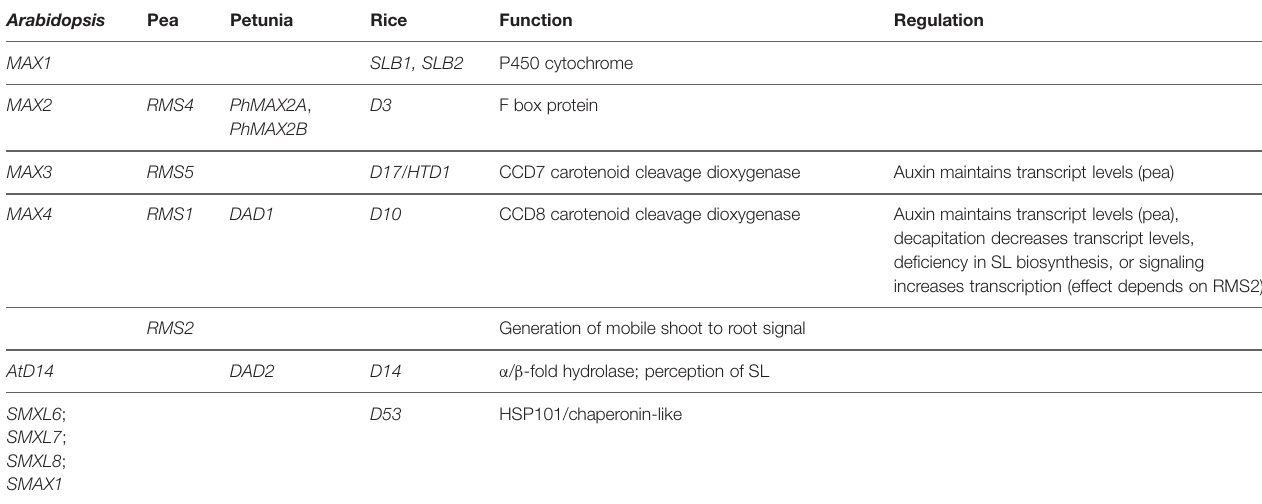
TABLE 1 | Genes involved in strigolactone biosynthesis and signaling.